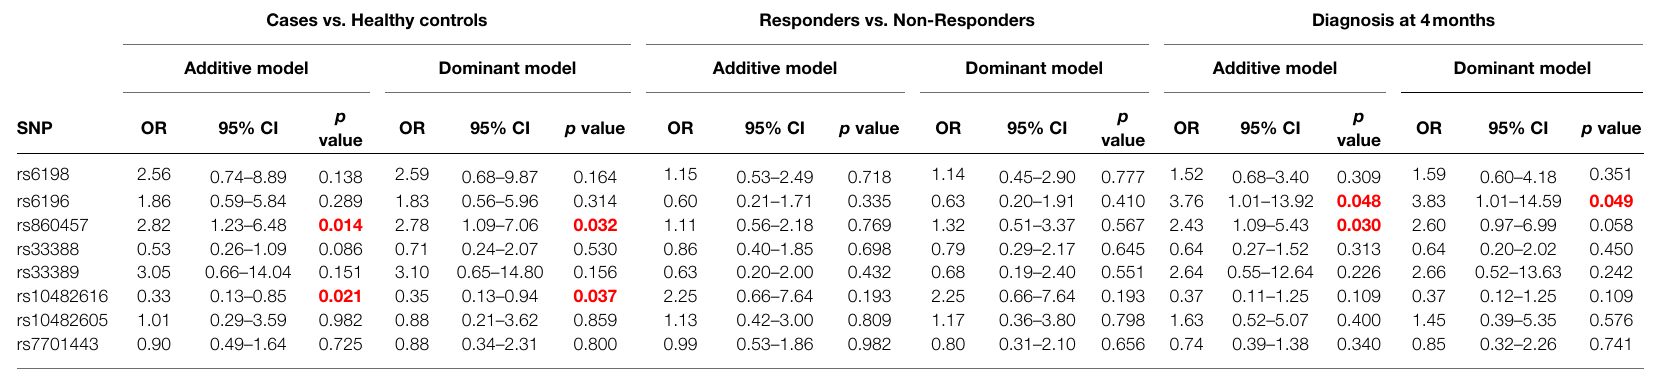
TABLE 3 | Statistical analyses with logistic regression (assuming either additive or dominant effect of the minor allele) of the SNPs in DBA and healthy controls, responders vs. non responders and age to disease manifestation before 4 months. Cases vs. Healthy